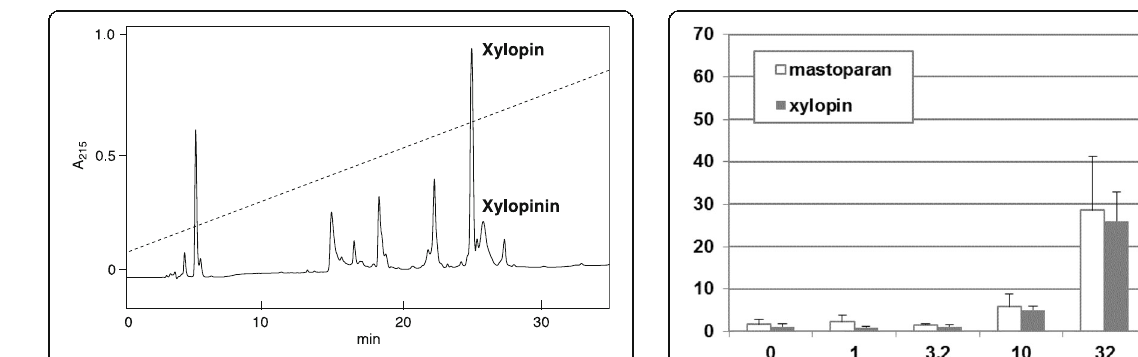
Fig. 2 Fractionation of venom extracts of Xylocopa appendiculata circumvolans by reverse-phase HPLC using CAPCELL PAK C 18 (6 × 150 mm) with linear gradient of 5 – 65% CH 3 CN/H 2 O/0.1% TFA over 30 min at flow rate of 1 mL/min. UV absorption was monitored at 215 nm